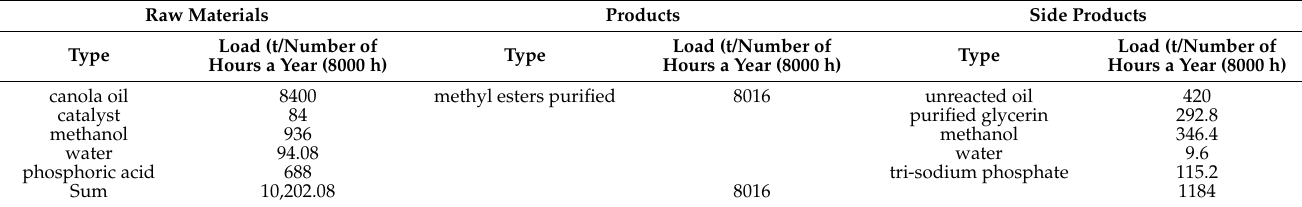
Table 11. The annual material balance of raw materials, products, and by-products of the transesterification process. Raw Materials Products Side Products Type